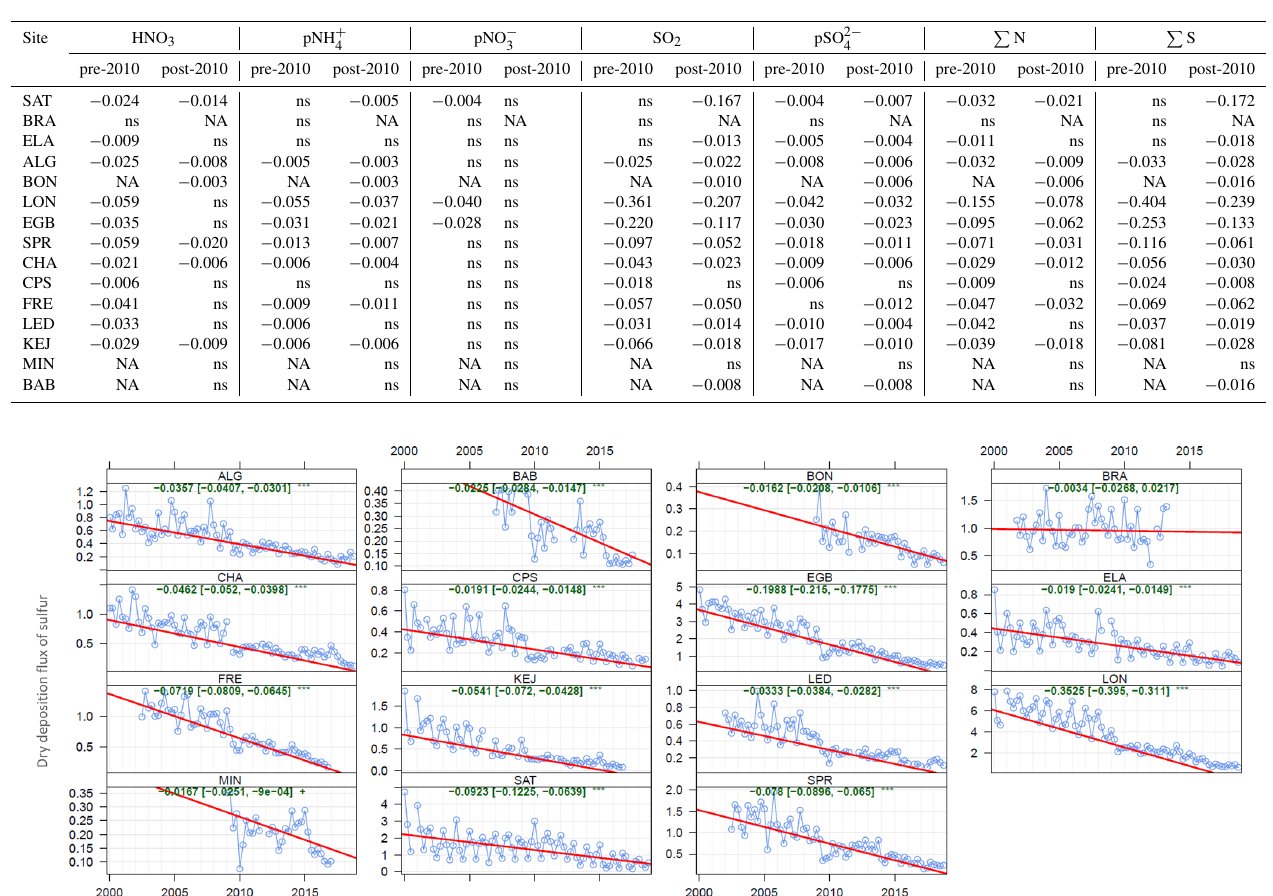
Table 4. Rate of change in annual dry deposition fluxes of N and S species (kgN or Sha − 1 yr − 1 ) at CAPMoN sites, based on Theil–Sen slopes (statistically significant at p < 0.05). Pre-2010: 2000–2009 period; post-2010: 2010–2018 period; NA: not available due to incomplete data; ns: trend is not statistically significant. Note: (cid:80) nitrogen excludes dry deposition of NH 3 and some oxidized nitrogen species.